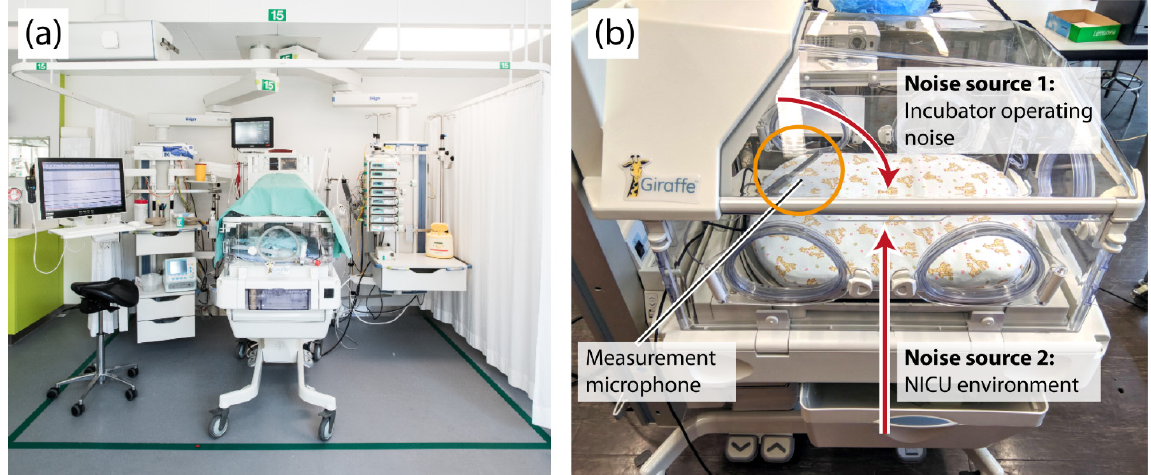
Figure 1. ( a ) Incubator in an NICU. In the picture, half of the top of the incubator is covered by a blanket to decrease the brightness inside the incubator. Image source: University Hospital Zurich; with permission. ( b ) Close-up of the incubator used in the study. The paths of two main sources of noise for the incubator are indicated by red arrows: sound coming from outside and inside. The orange circle indicates the position of the measurement microphone.